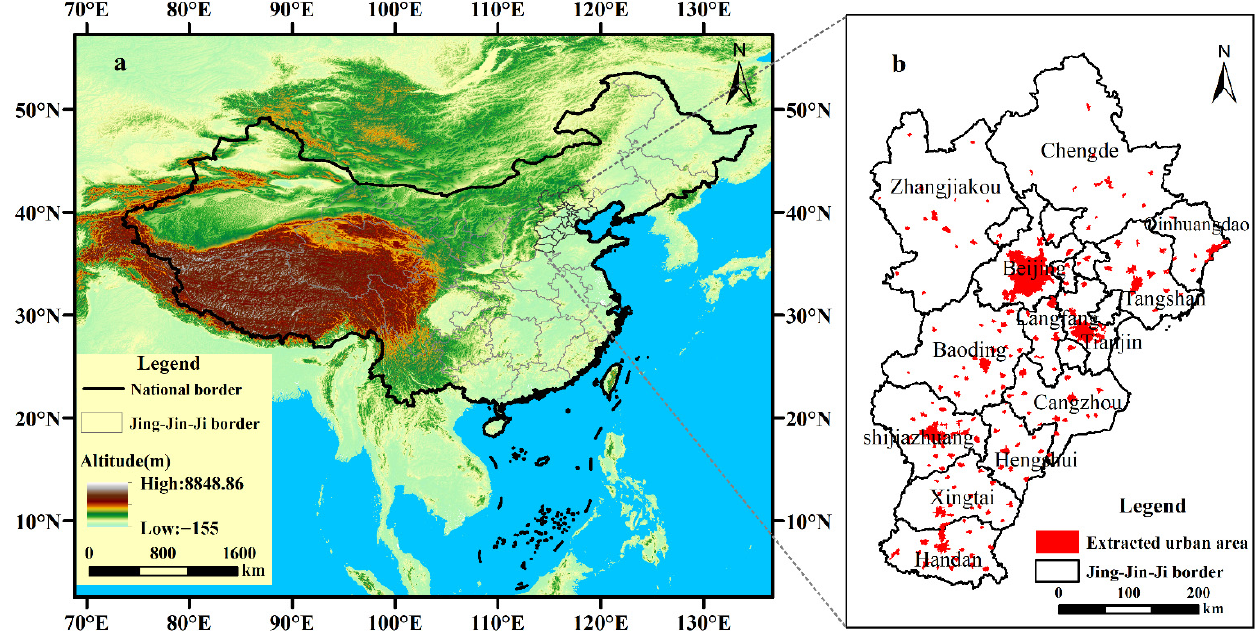
Figure 1. Study area in Beijing–Tianjin–Hebei. (Note that the location of Beijing-Tianjin-Hebei in China ( a ). The merging and screening of the urban boundary and non-urban land patches were based on the land use status in different periods according to the degree of patch continuity and the influence of the ocean or cities in other provinces; the continuous patches were therefore taken as a research unit, whereas those affected by sea water and inaccurate classification were deleted. This screening and merging process yielded a total of 156 urban areas ( b ), which are independent of each other and continuous in time, and are not affected by the ocean or adjacent patches).